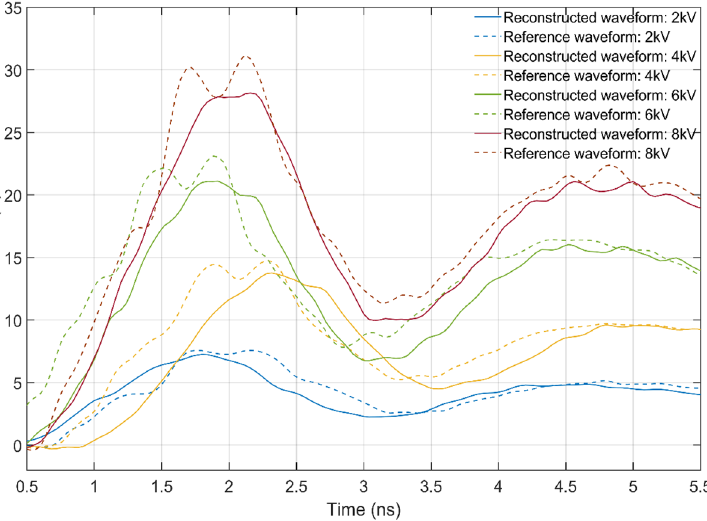
Figure 14. Initial peak comparison of the reconstructed waveform (straight lines) with the Pellegrini target (reference) waveform (dotted lines) for a +2 kV (blue), +4 kV (yellow), +6 kV (green) and +8 kV (red) pulse of the EM Test Dito generator.